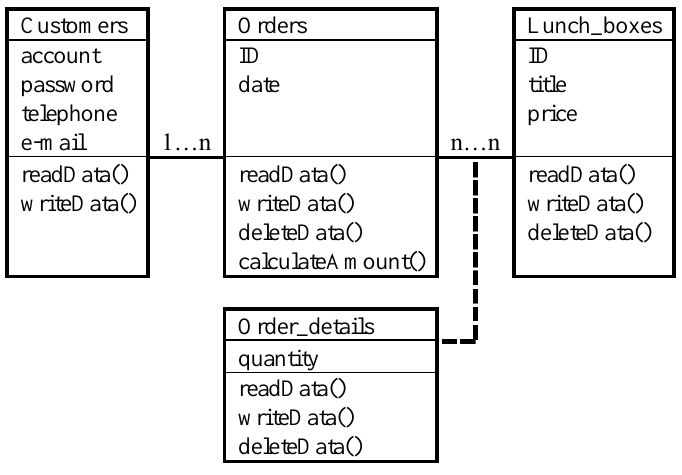
Figure 5. An example of a class diagram in an object database.